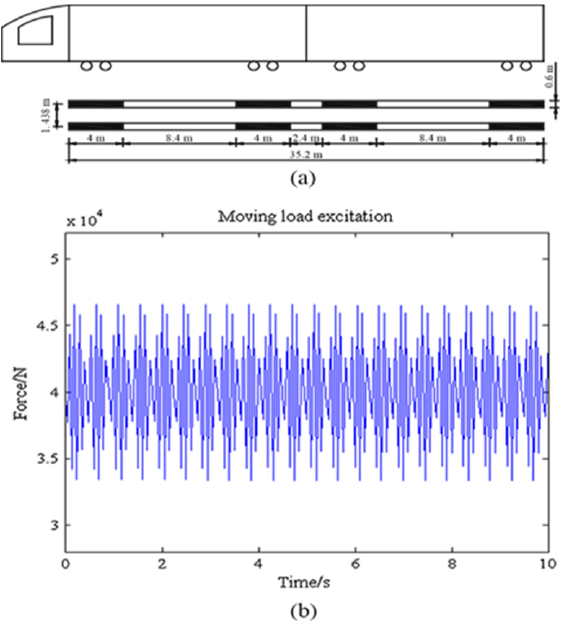
Figure 9. The simulated load (moving): ( a ) moving trainload; and ( b ) time domain force of each of the wheel action